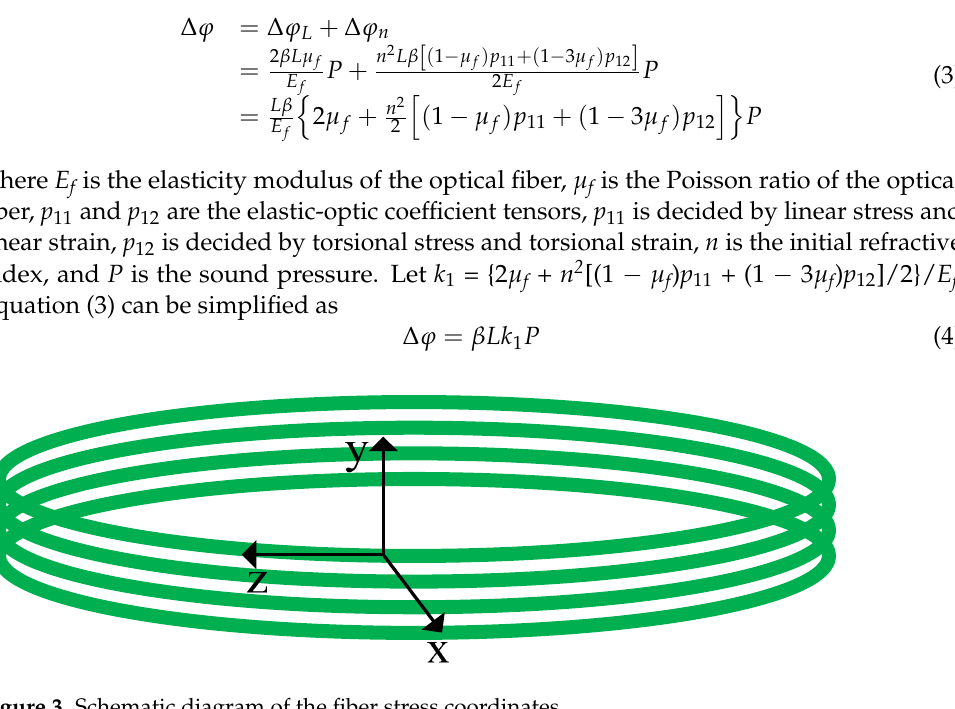
Figure 3. Schematic diagram of the fiber stress coordinates. When the optical fiber is tightly wound around the outer wall of the elastic cylinder, the phase change of the optical fiber not only comes from the effect of the sound field but can also be influenced by the elastic cylinder. When the elastic cylinder is put in the sound field, it can be approximated that the force from the sound field is uniform. The equilibrium state equation of the elastic cylinder